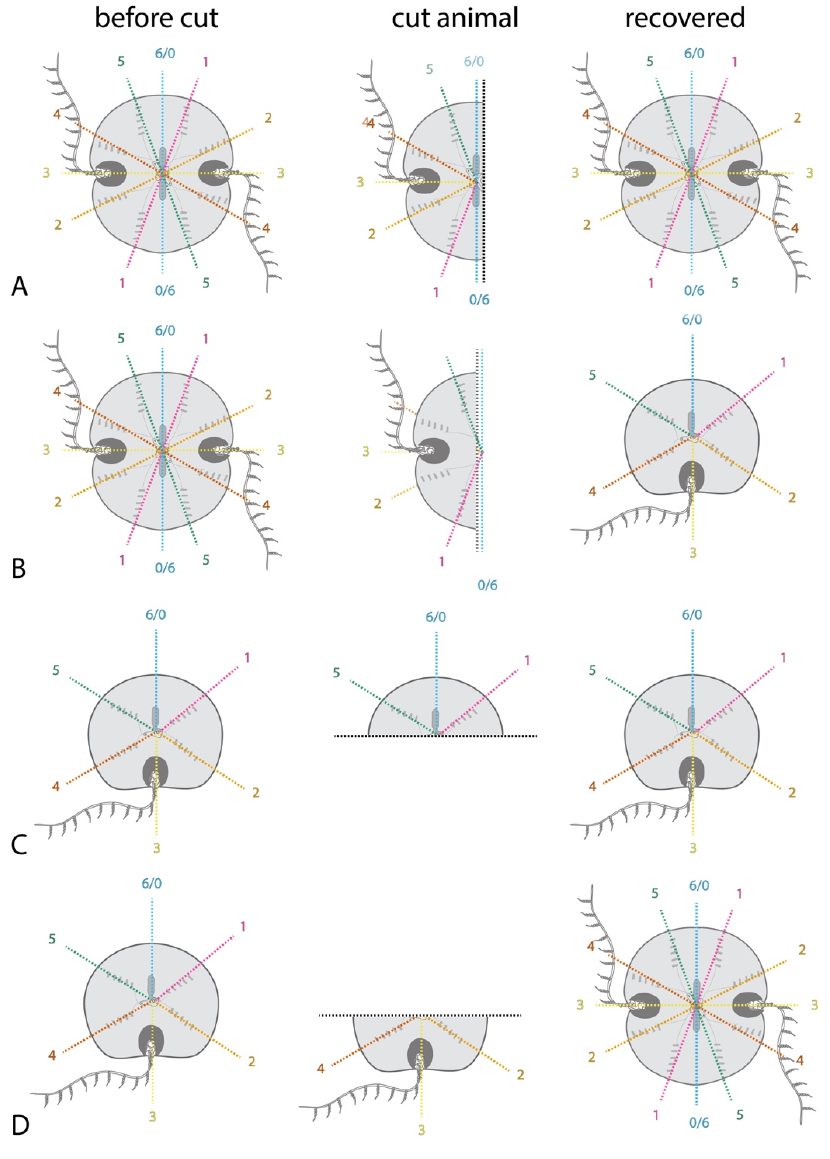
Figure 3. The apical organ serves as an organizing center to pattern the body axes during regeneration. The polar coordinate system of the ctenophore’s biradial body plan is indicated with differently colored lines for each plane of mirror symmetry; the identity of these planes is conventionally designated with a number as shown. ( A ) When a normal animal is bisected sparing the apical organ, it most often regenerates into a whole animal with two of each body part. ( B ) When the apical organ is not present, the bisected half may regenerate into a normal animal as in ( A ) but is more likely to become a stable half animal with one (instead of two) of each body part and no planes of mirror symmetry. The half-animal includes one tentacle bulb, one anal pore, half an apical organ, and half the normal complement of comb rows. ( C ) A “stable half-animal”, as generated in ( B ) or through embryonic deletion of half the body structures, can be bisected again. The fragment with the retained “half apical organ”, regenerates into a half animal. ( D ) In contrast, the fragment of the “half animal” lacking any apical organ can regenerate into an animal with all the body parts and axes of mirror symmetry present in a normal animal, including a whole apical organ. These results strongly suggest that the apical organ directs patterning when present. Removal of a half apical organ, which would otherwise direct patterning into a half-animal, allows the animal fragment lacking an apical organ to re-pattern normally (as a minority of animals cut as in ( B ) would do).